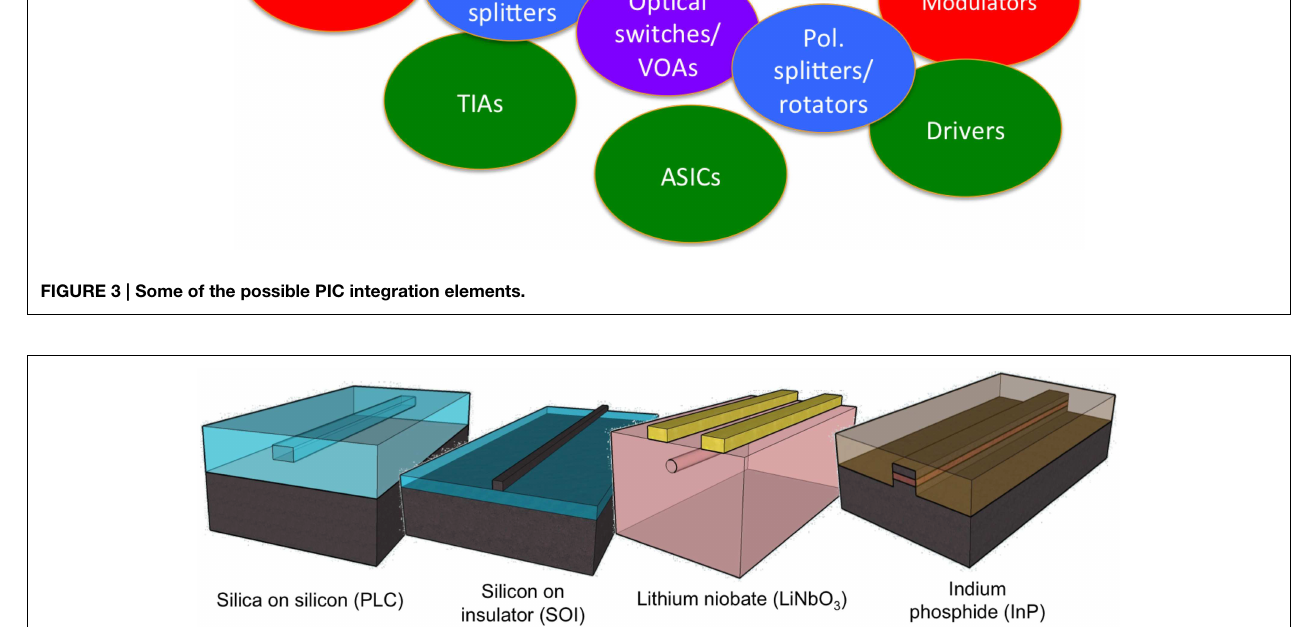
Frontiers in Physics |